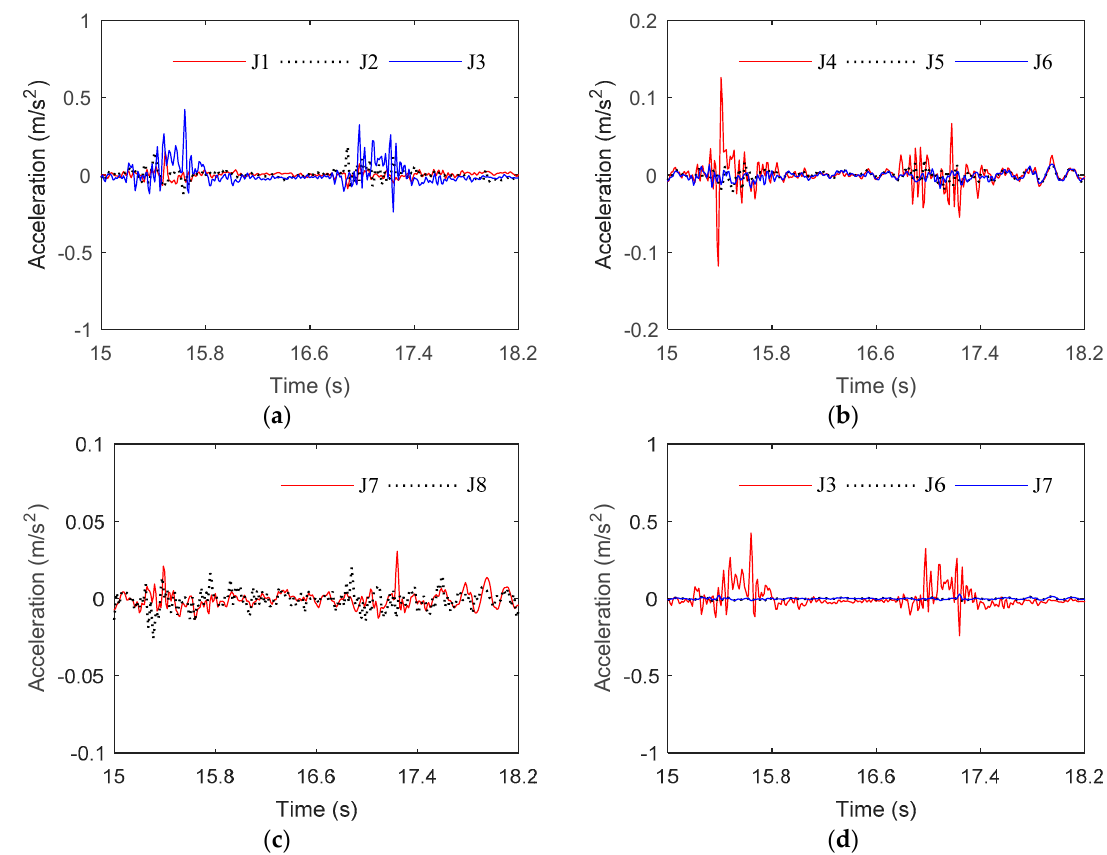
Figure 12. Time-series of the acceleration response at various measurement positions in wave condition A5. ( a ) J1, J2, J3; ( b ) J4, J5, J6; ( c ) J7, J8; ( d ) J3, J6, J7.